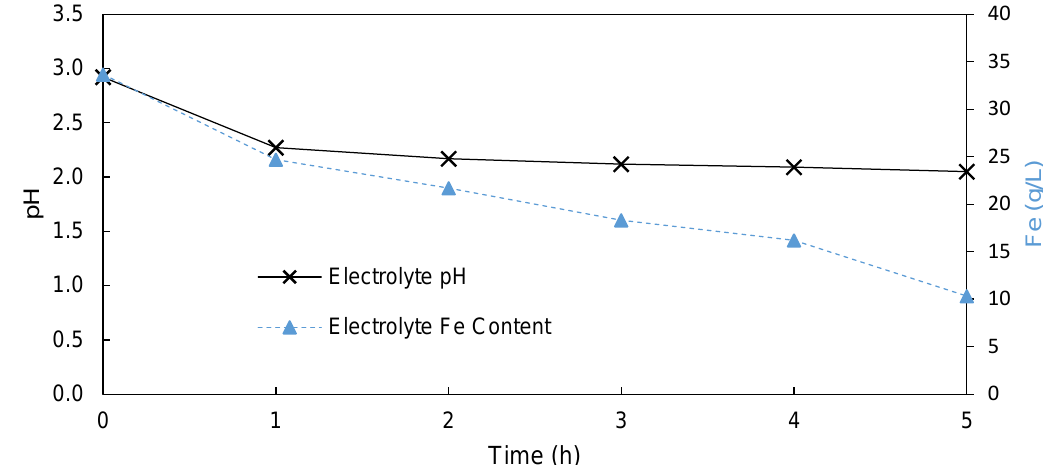
Figure 2. Change in the pH (primary y -axis) and Fe content (secondary y -axis) of the electrolyte during electrowinning (EW) in an undivided cell.